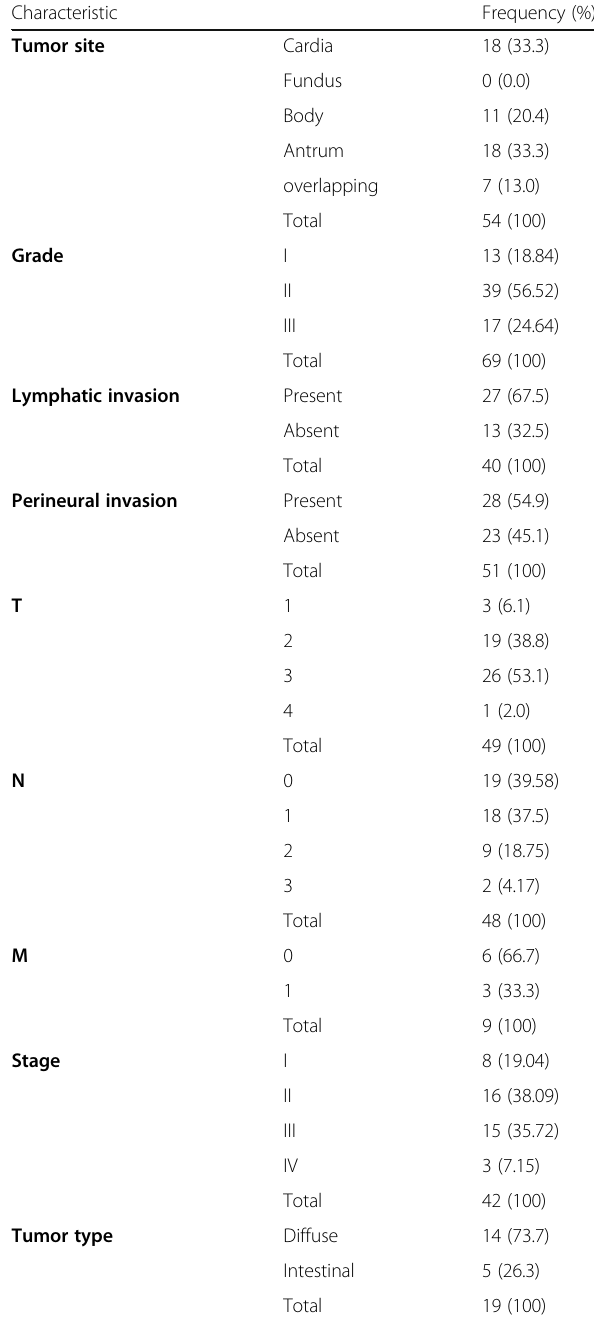
Table 2 Tumor characteristics, including tumor site, tumor grade, lymphatic invasion, perineural invasion, tumor stage